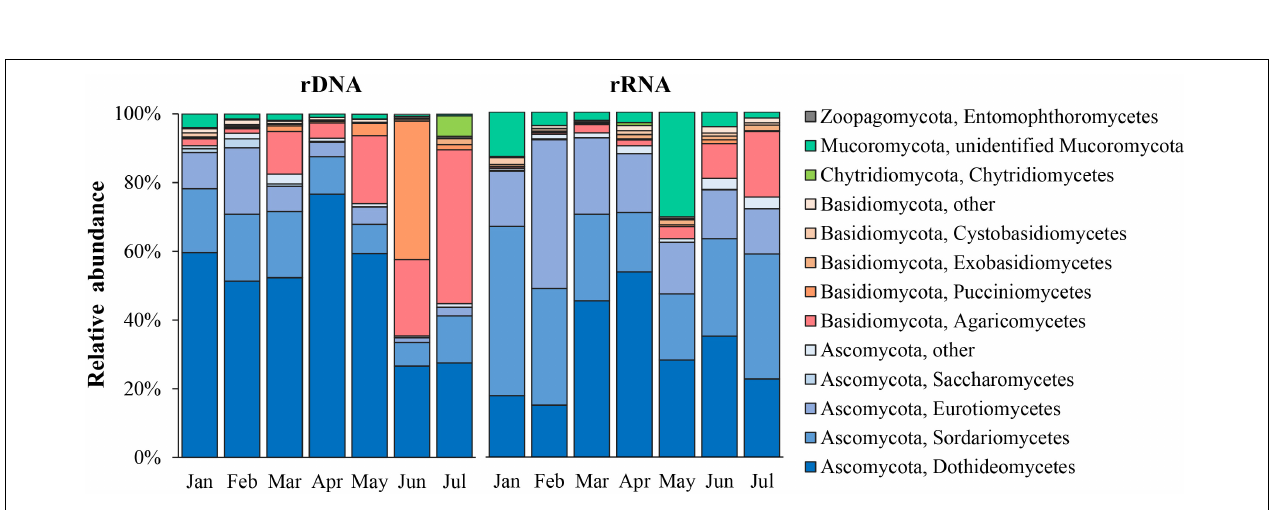
FIGURE 2 | Class-level taxonomic composition of rRNA and rDNA fungal communities in the atmosphere.